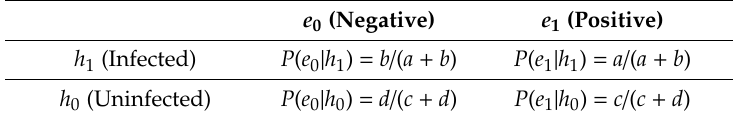
Table 3. The semantic channel ascertained by two degrees of disbelief b 1 ′ and b 0 ′ .